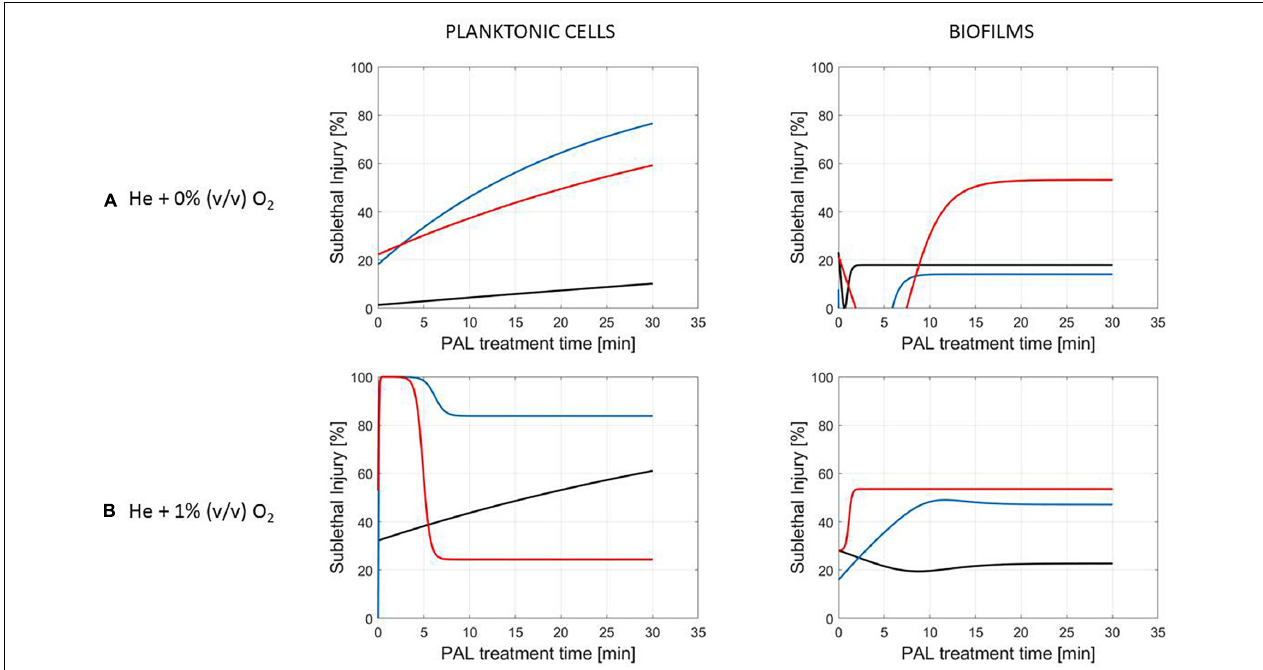
FIGURE 5 | Evolution with time of the sublethal injury (%) of L. monocytogenes planktonic cells and biofilms toward the plasma activated liquid treatment time. Plasma activated liquids were created using two different gas compositions (A) He + 0% (v/v) O 2 or (B) He + 1% (v/v) O 2 , and three different generation times (10, 20, and 30